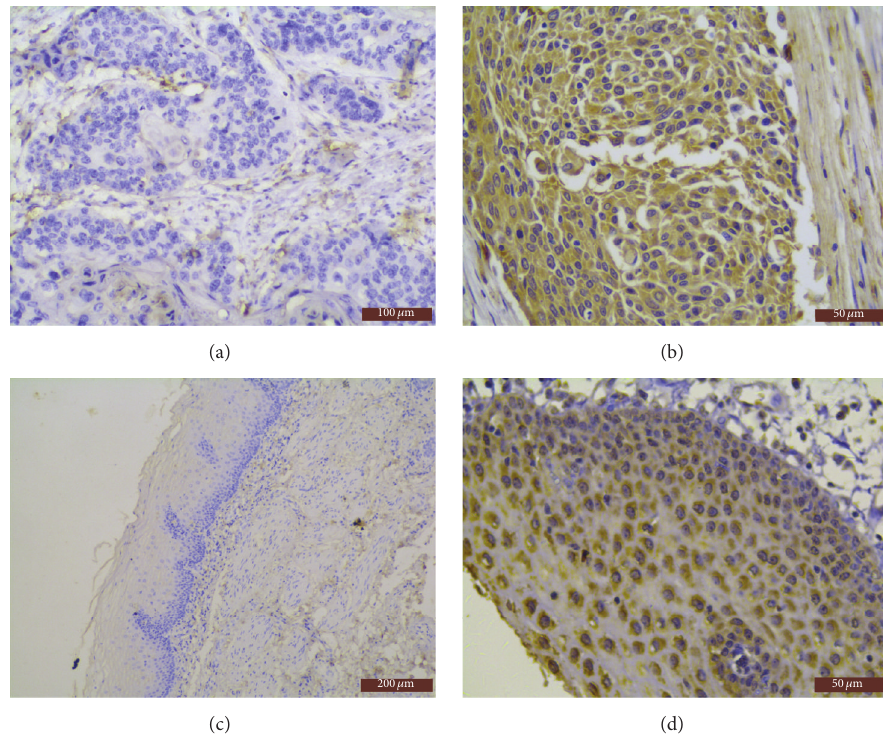
Figure 1: Representative immunohistochemical staining results for CADM1/TSLC1 in tissues of ESCC and normal esophageal tissues. (a) Negative expression of CADM1/TSLC1 in ESCC tissues (SP × 200 magnification); (b) positive expression of CADM1/TSLC1 in ESCC tissues (SP × 400 magnification); (c) negative expression of CADM1/TSLC1 in normal esophageal tissues (SP × 100 magnification); (d) positive expression of CADM1/TSLC1 in normal esophageal tissues (SP × 400